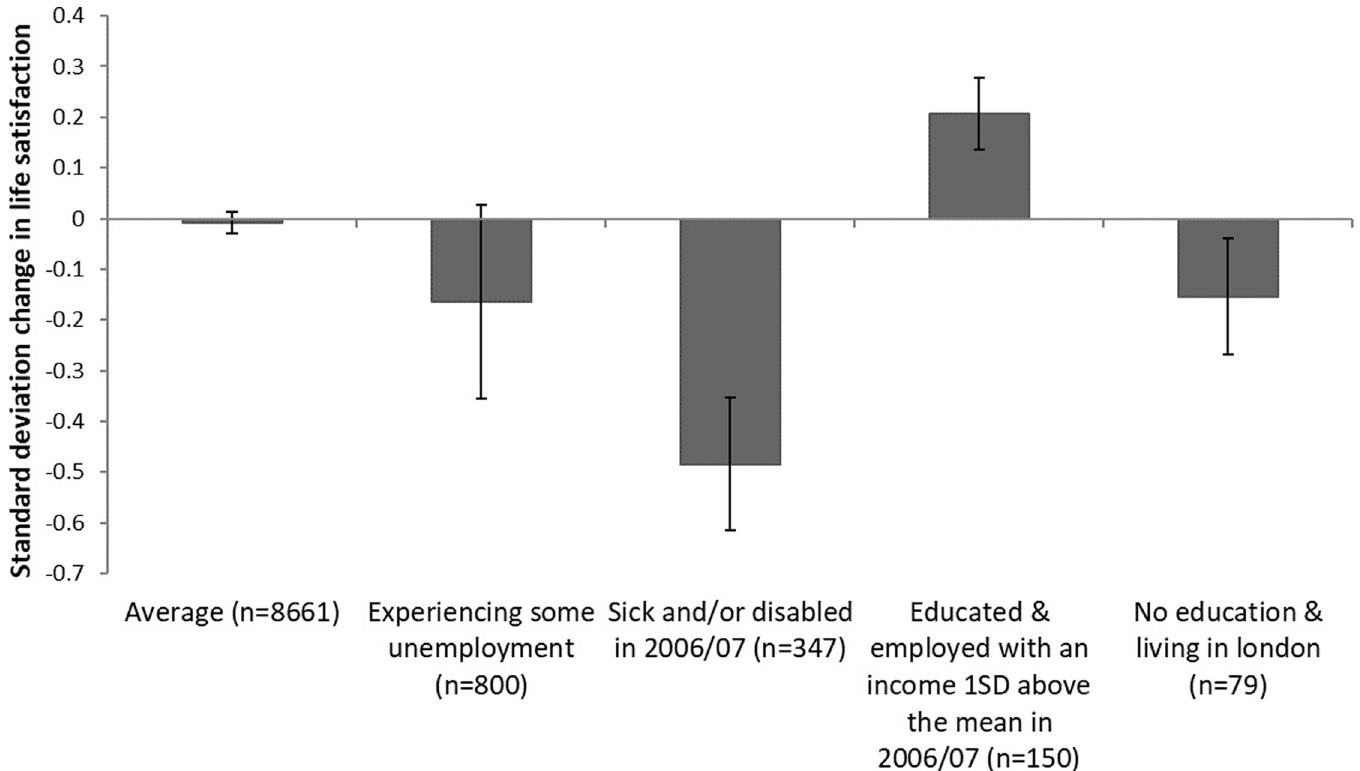
Fig 2. Changes in life satisfaction following the Great Recession for different identifiable groups of